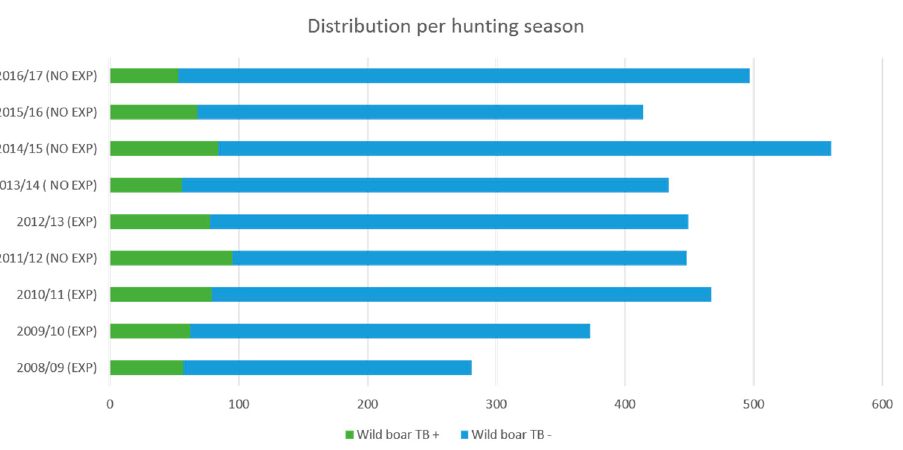
Figure 3. Graphics with wild boar TBL occurrence in exposed and non-exposed hunting seasons. The risk factor “previous hunting season with periods of drought” revealed a statis- tically significant association ( p < 0.05) with the incidence of TBL in wild boars in Idanha- a-Nova County during the nine hunting seasons considered in the study. We found that when one hunting season had some periods of drought, the probability of TBL incidence in wild boars was 1.2 (OR = 1.2) times higher in the next hunting season compared to when there were no periods of drought.